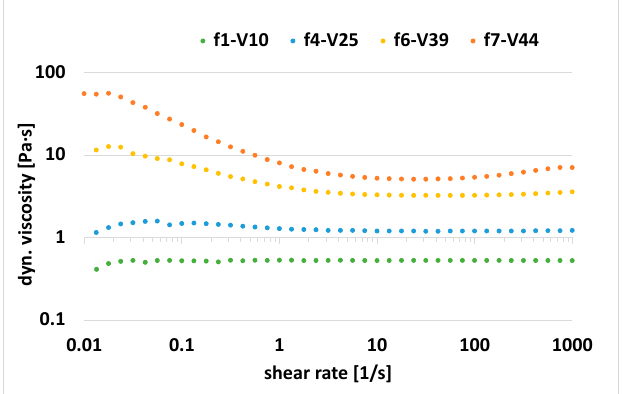
Figure 2. Dynamic viscosity dependent upon shear rate for AlN suspensions with varying solid content (10, 25, 39 and 44 vol%).